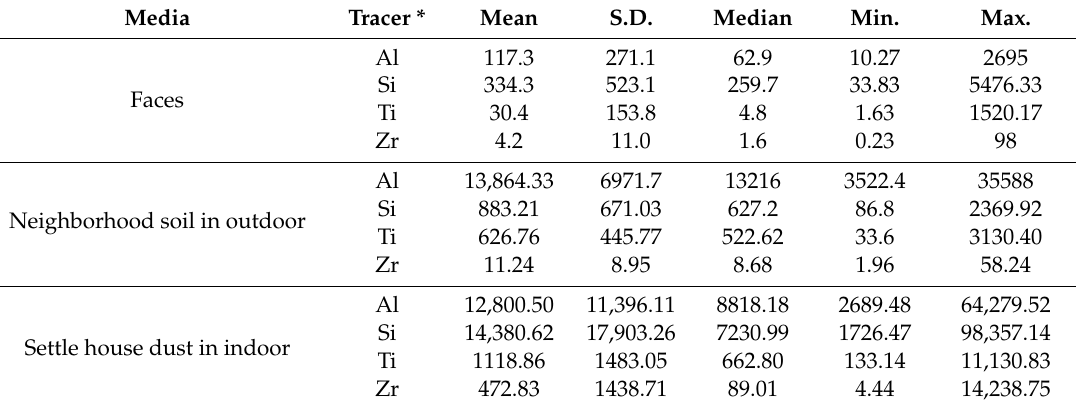
Table 9. Concentration (mg / kg, n = 113) of tracers in children’s feces, neighborhood soil, and indoor dust at